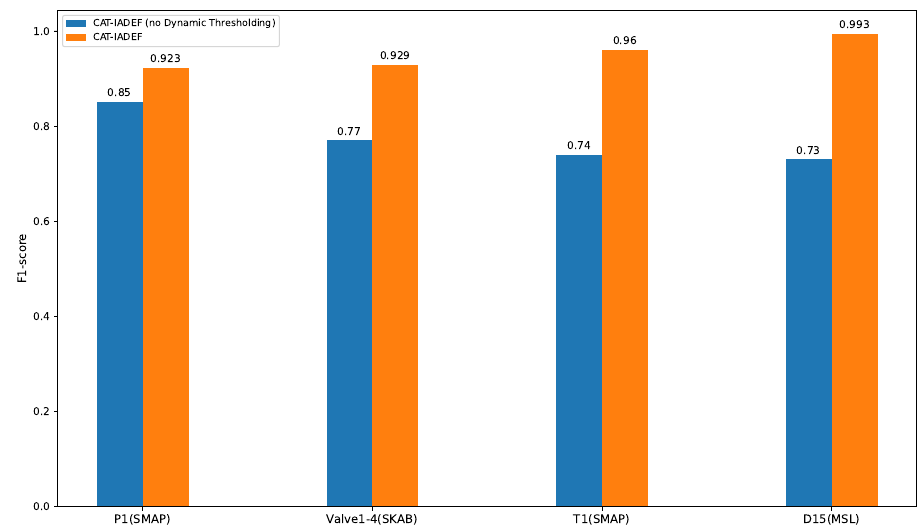
Figure 4. Performance comparison between dynamic threshold and dynamic threshold (no dynamic threshold) datasets.